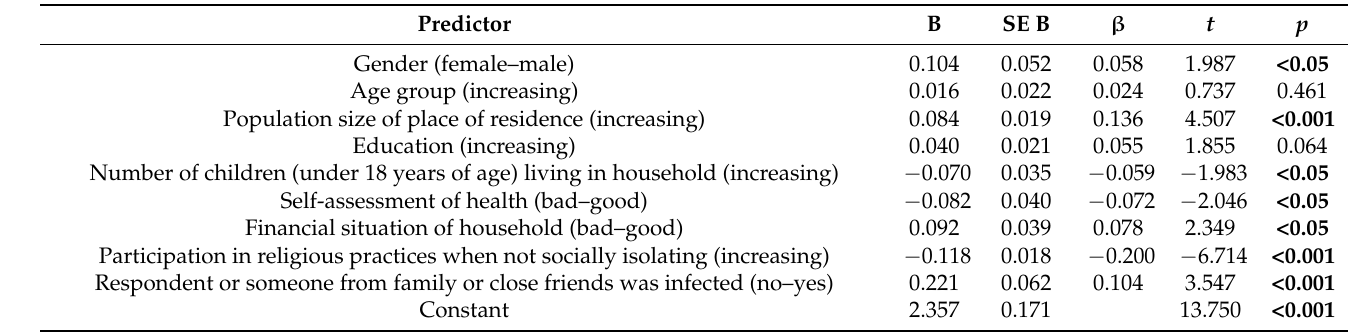
Table 2. The results of the linear regression analysis predicting the trust index score (continuous variable) from socio-demographic characteristics ( n = 1072).